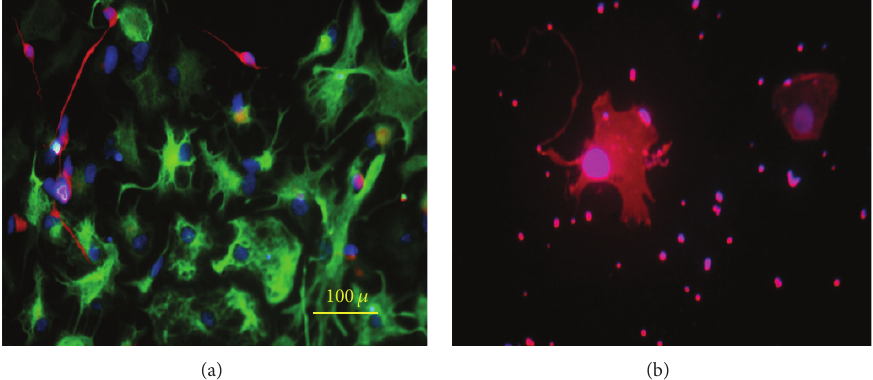
Figure 5: (a) Neurons and astrocytes differentiated from breast milk stem cells-derived neural stem cell stained with anti- 𝛽 -tubulin-Alexa Flour 568 (red) and anti-GFAP-Alexa Flour 488 (green); (b) oligodendrocyte differentiated from breast milk stem cell-derived neural stem cell stained with anti-O4-Alexa Flour